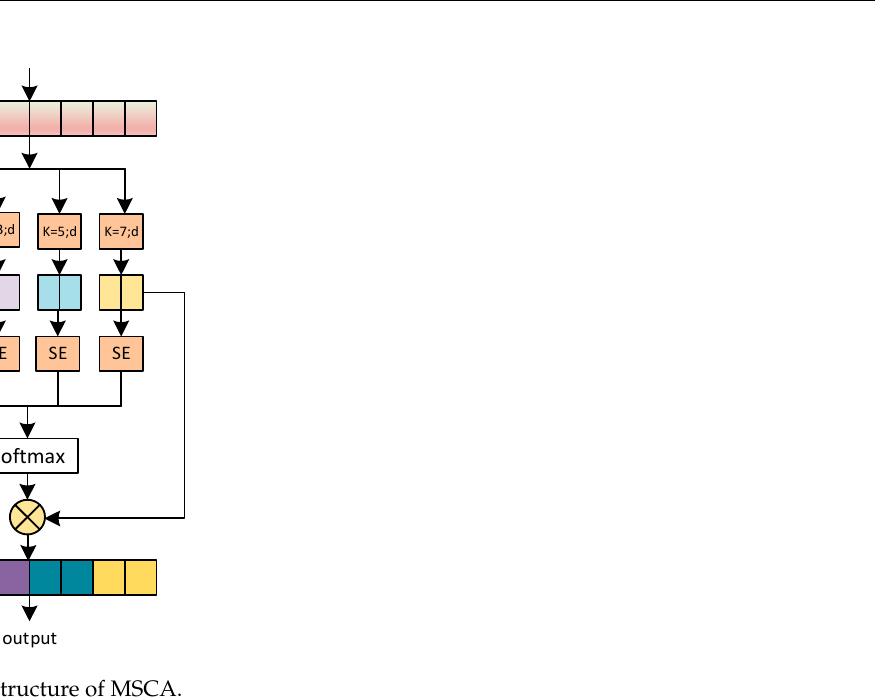
Figure 3. MSCA-Res2Block.